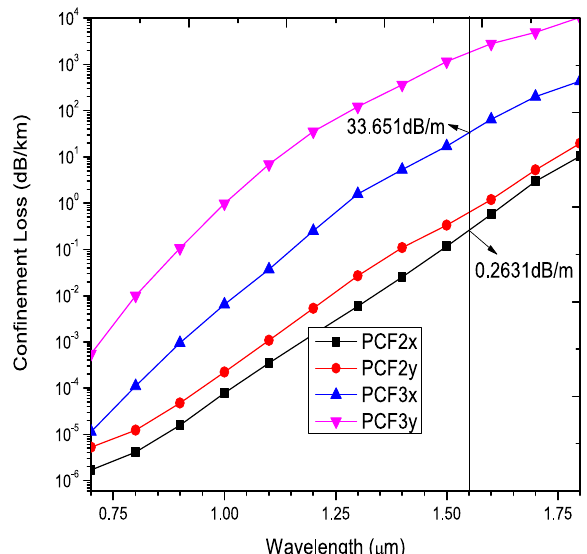
Fig. 11 Variation of confinement loss as a function of wavelength for PCF2 and PCF3